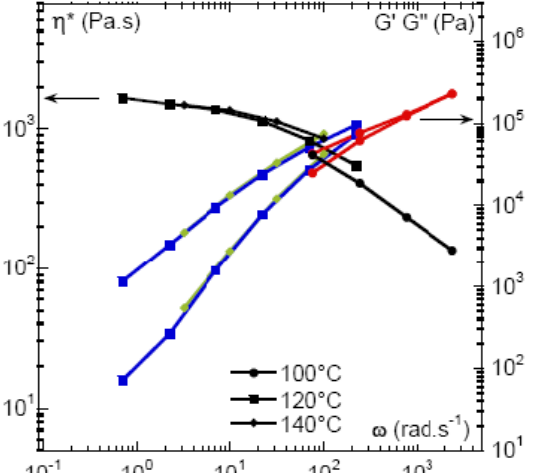
Figure 9. Time-Temperature Superposition obtained for SPSFH (IEC = 1.35 H + /kg) blended with 30%